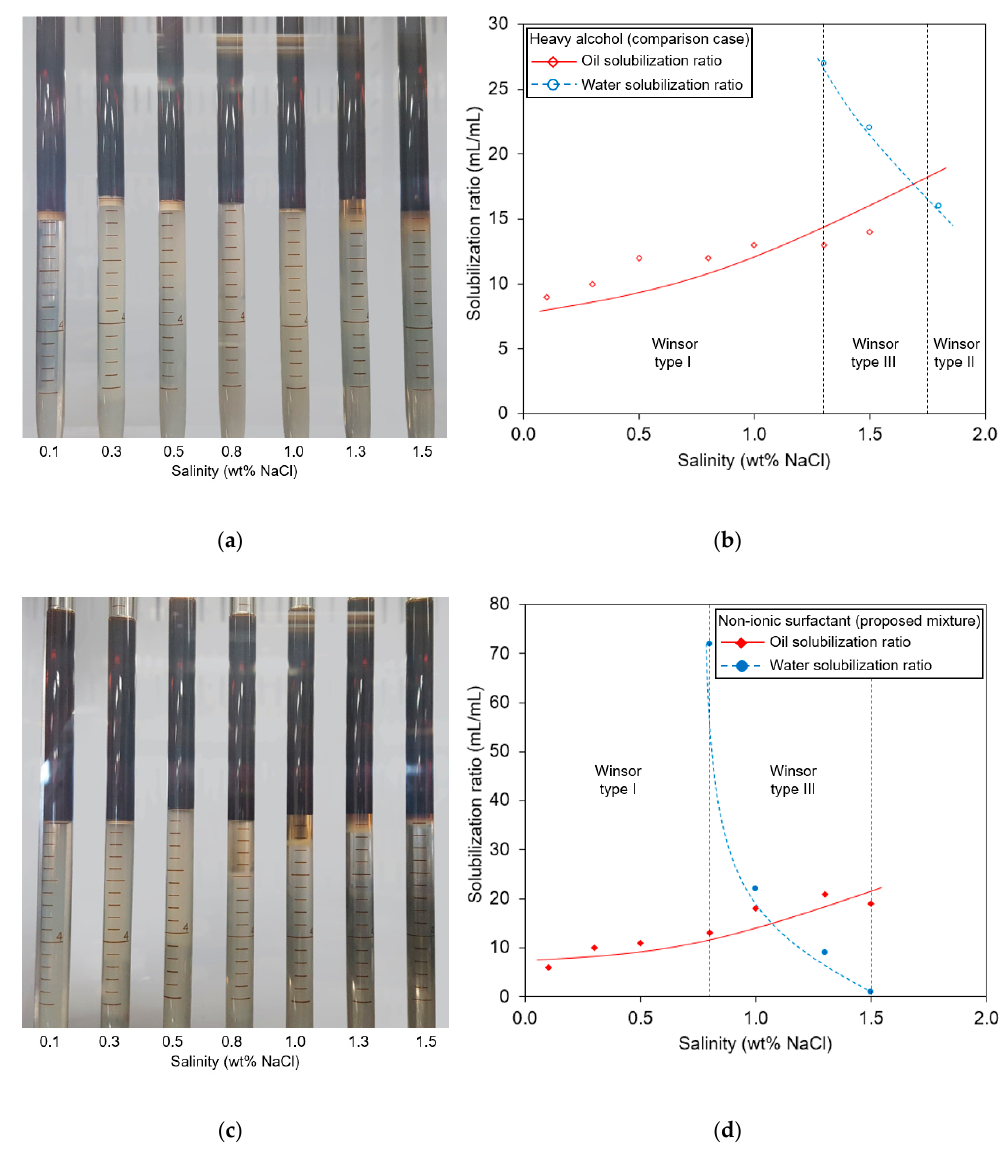
Figure 4. Salinity scan test: ( a , b ) as the reference case (heavy alcohol); ( c , d ) as the proposed mixture (nonionic surfactant). The left-hand side ( a , c ) shows microemulsions with the Winsor type III and the right-hand side ( b , d ) describes the solubilization ratio with the salinities. ‘ME’ stands for